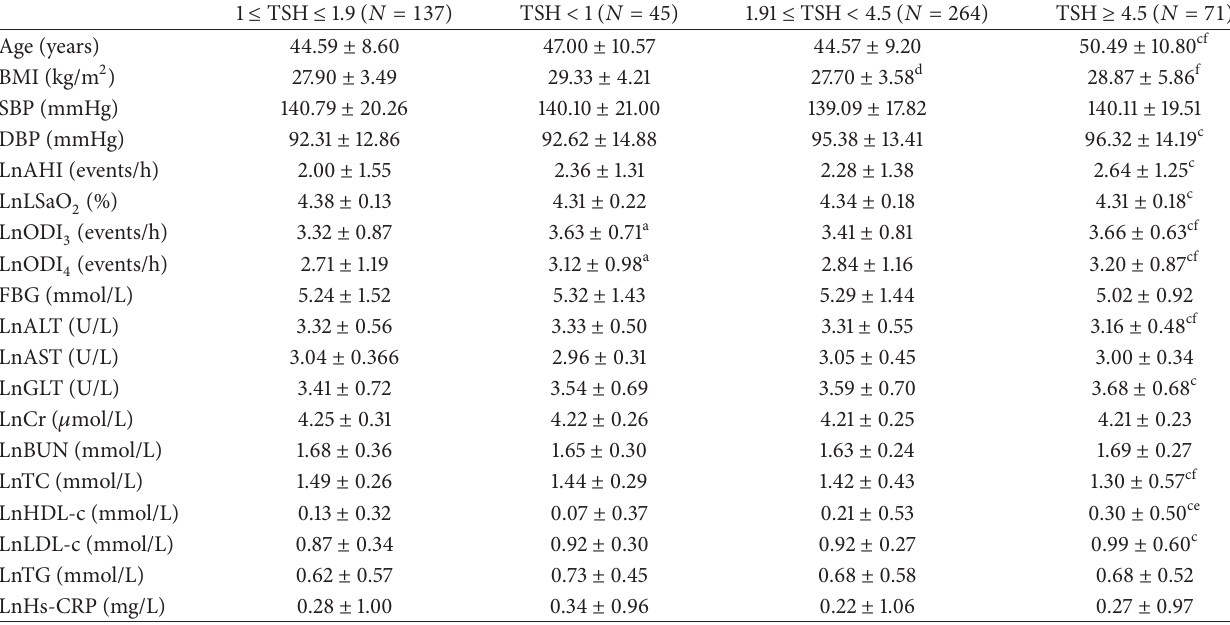
Table 4: Comparison of demographic and polysomnographic characteristics and biochemical markers in subjects with different serum TSH